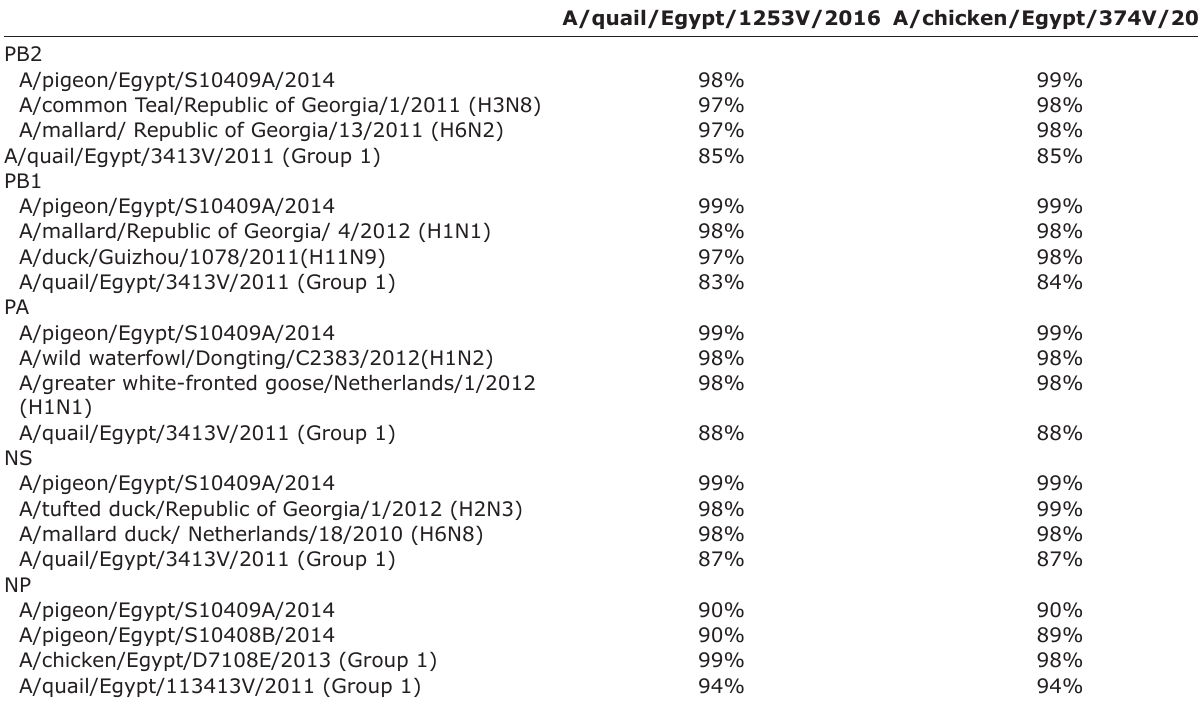
Table-1: Similarity percent among internal genes of parent viruses with the novel reassortant Egyptian H9N2 virus.